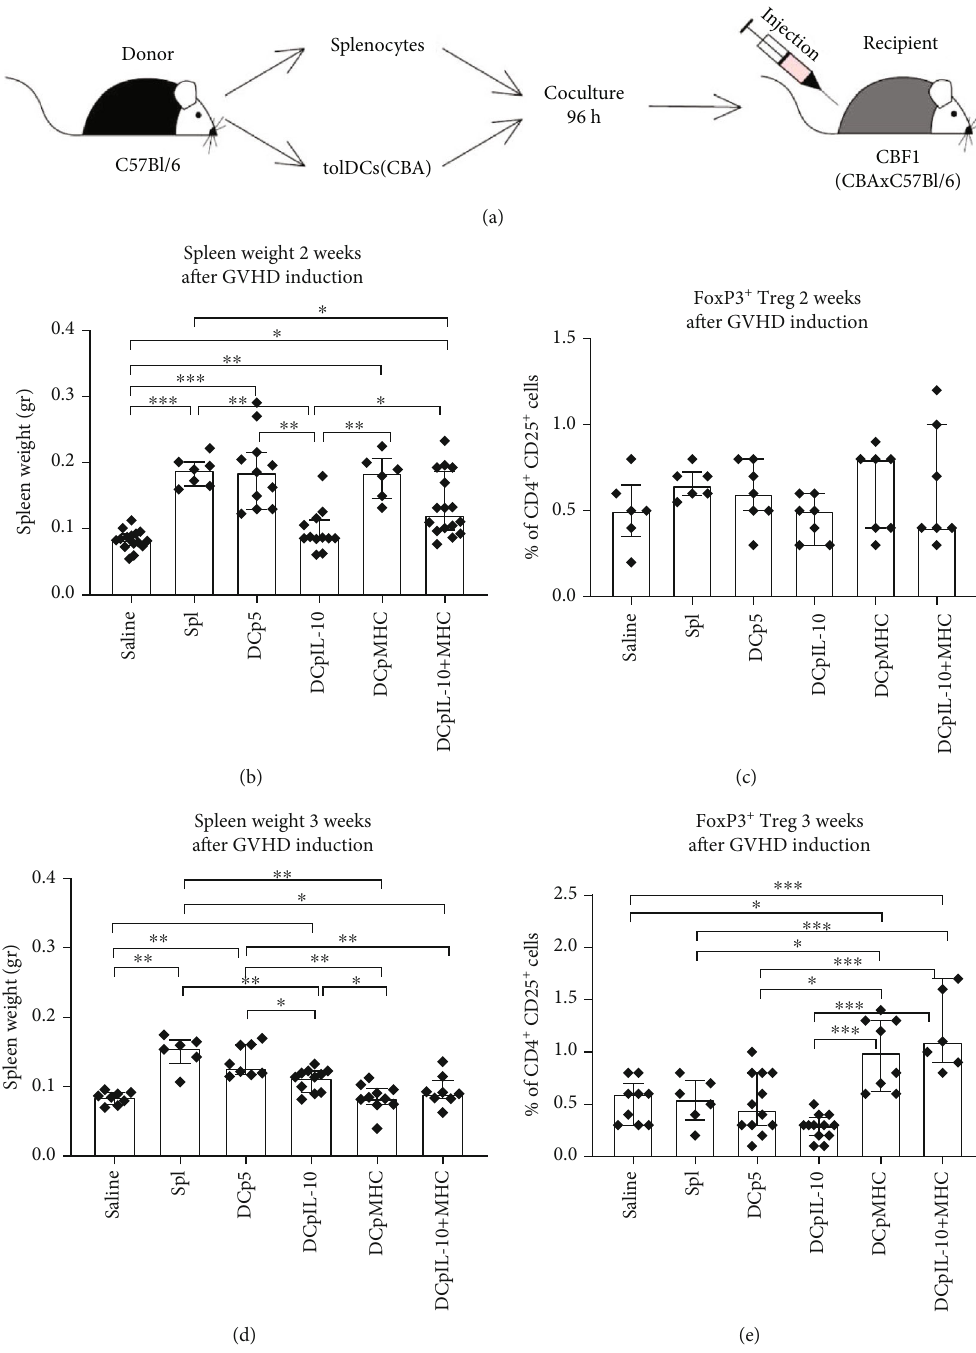
Figure 5: Induction of GVHD in CBF1 (F1: C57BL/6 × CBA) mice by splenocytes cocultured with the transfected DCs. (a) A GVHD induction scheme. Spleen weights were measured (b) 2 weeks or (d) 3 weeks after induction of GVHD ( N = 10 per group; the Kruskal-Wallis test with Dunn ’ s corrected multiple comparisons, P ≤ 0 : 05 ). Frequencies of FoxP3 + Tregs were measured in mouse spleens (c) 2 weeks or (e) 3 weeks after induction of GVHD ( N = 7 per group; one-way ANOVA with Tukey ’ s corrected multiple comparisons, P ≤ 0 : 05 ). Median and interquartile range. Brackets indicate signi fi cant di ff erences, ∗ P < 0 : 05 , ∗∗ P < 0 : 01 , ∗∗∗ P < 0 : 001 . Saline: administration of saline; Spl: administration of C57BL/6 mouse splenocytes; DCp5: administration of cocultures of autosplenocytes and DCs electroporated with a control plasmid p5; DCpIL-10: administration of cocultures of autosplenocytes and DCs electroporated with a pIL-10; DCpMHC: administration of cocultures of autosplenocytes and DCs electroporated with a pMHC; DCpMHC + IL-10: administration of cocultures of autosplenocytes and DCs electroporated with pMHC and pIL-10